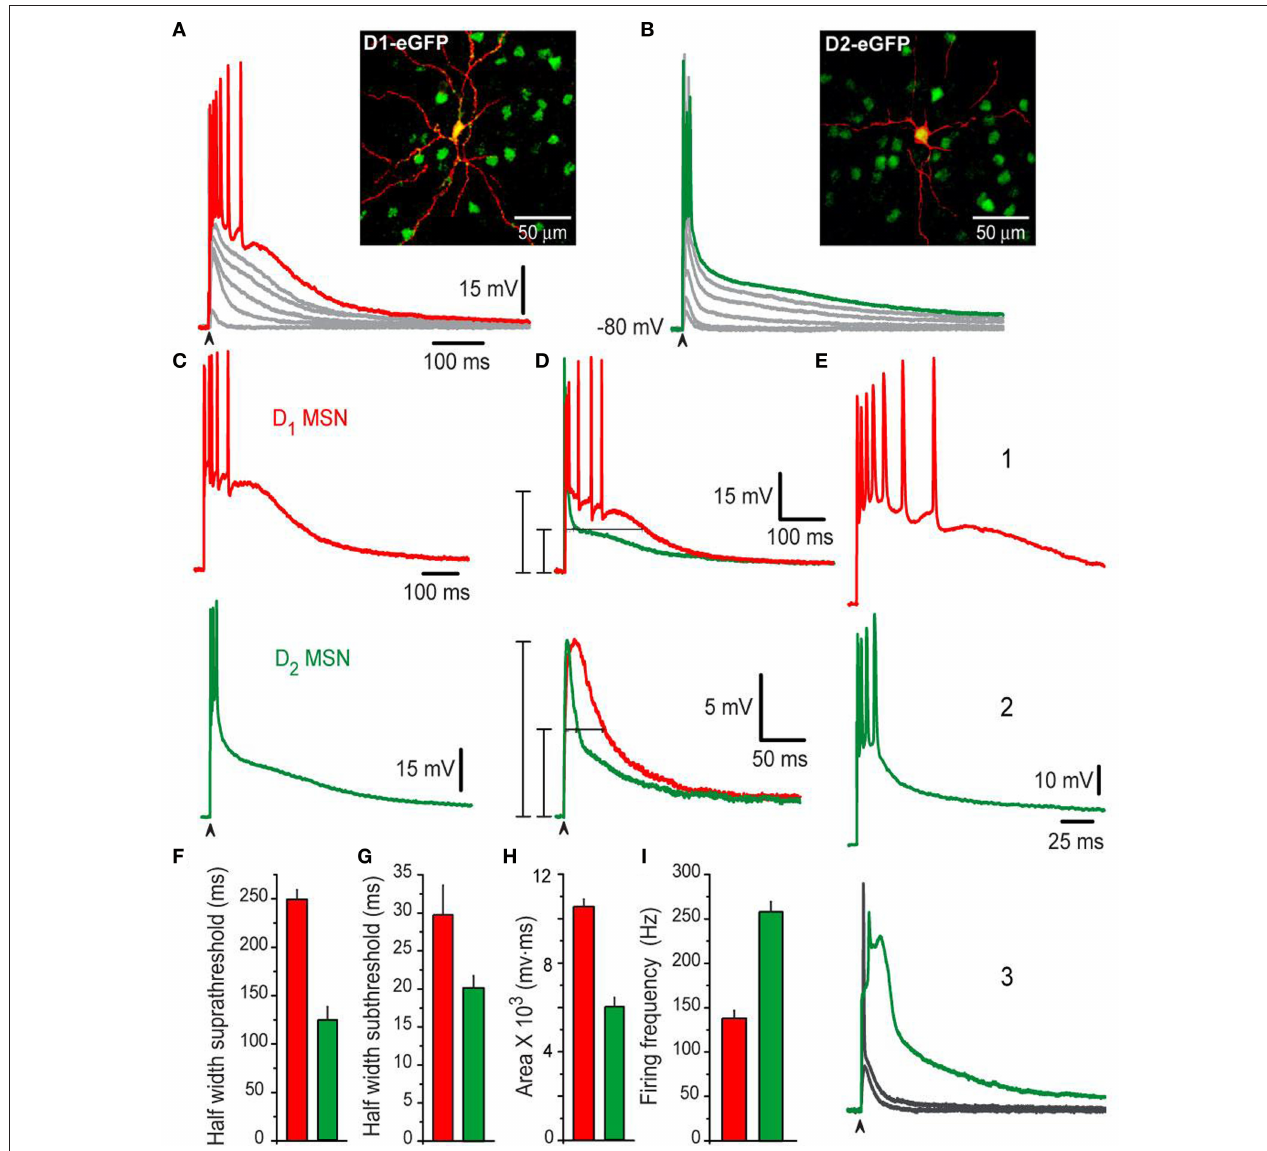
FiGure 1 | Different corticostriatal response in D spiny neurons (MSNs) from BAC mice. (A,B) Families of subthreshold and suprathreshold corticostriatal synaptic responses for representative D traces) and D - (green traces) MSNs obtained from BAC transgenic mice 2 striatum. Insets show biocytin-filled recorded cells and green fluorescent protein positive (GFP + ) accompanying cells (insets). Yellow color of recorded cells indicate D - (A) and D -eGFP-positive cells (B), respectively (superimposition). 1 2 Notice that